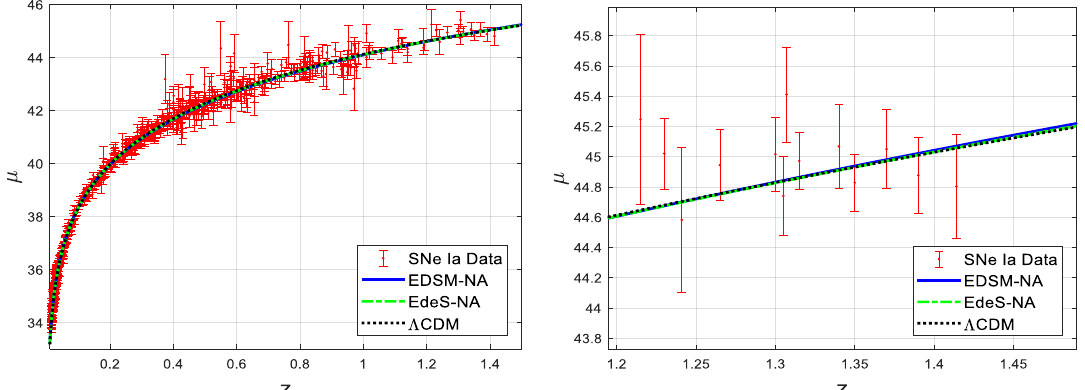
Figure 1. Fitted data curves for the three models in Table 1. The first one has been labeled as EDSM-NA since it is the nonadiabatic version of the EDSM model (flat, matter only, including Mach